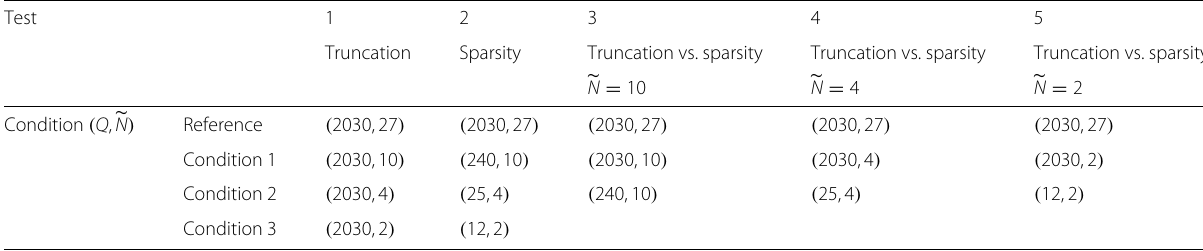
Table 1 The listening experiments test